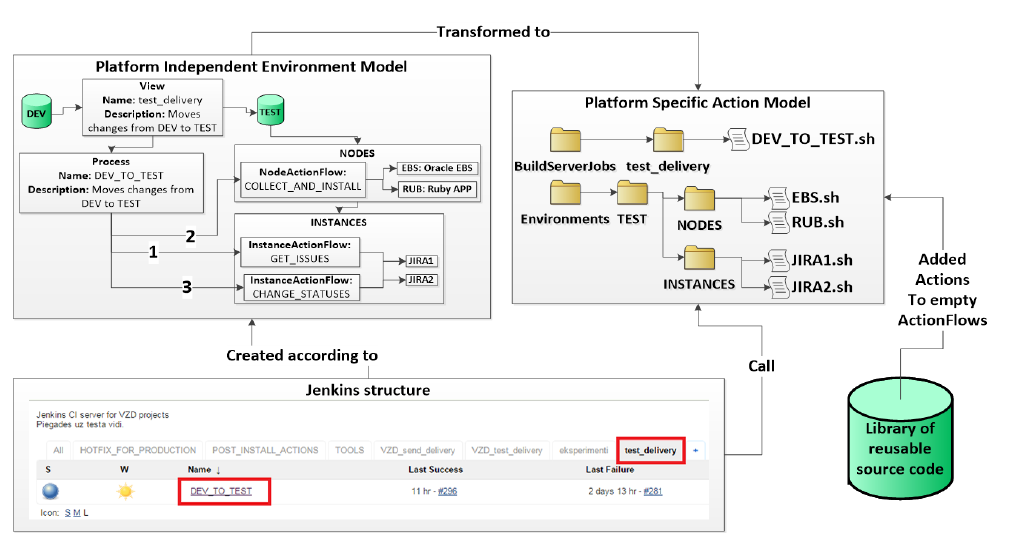
Fig. 7. Use case for a model-driven approach.